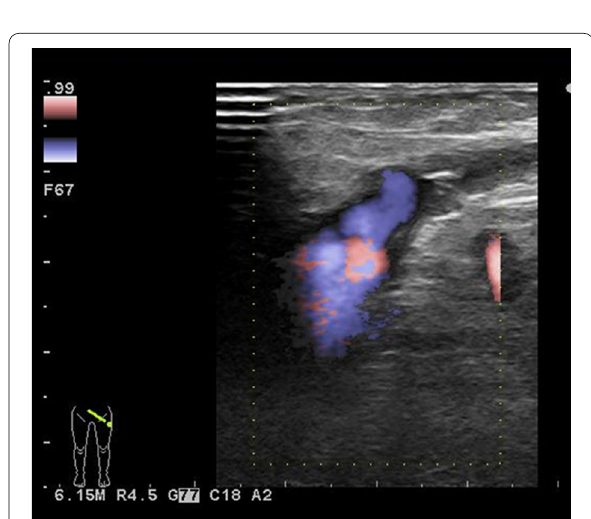
Fig. 3 Follow-up duplex sonography revealed that the success of EVLA of the left GSV and the patency of the deep vein